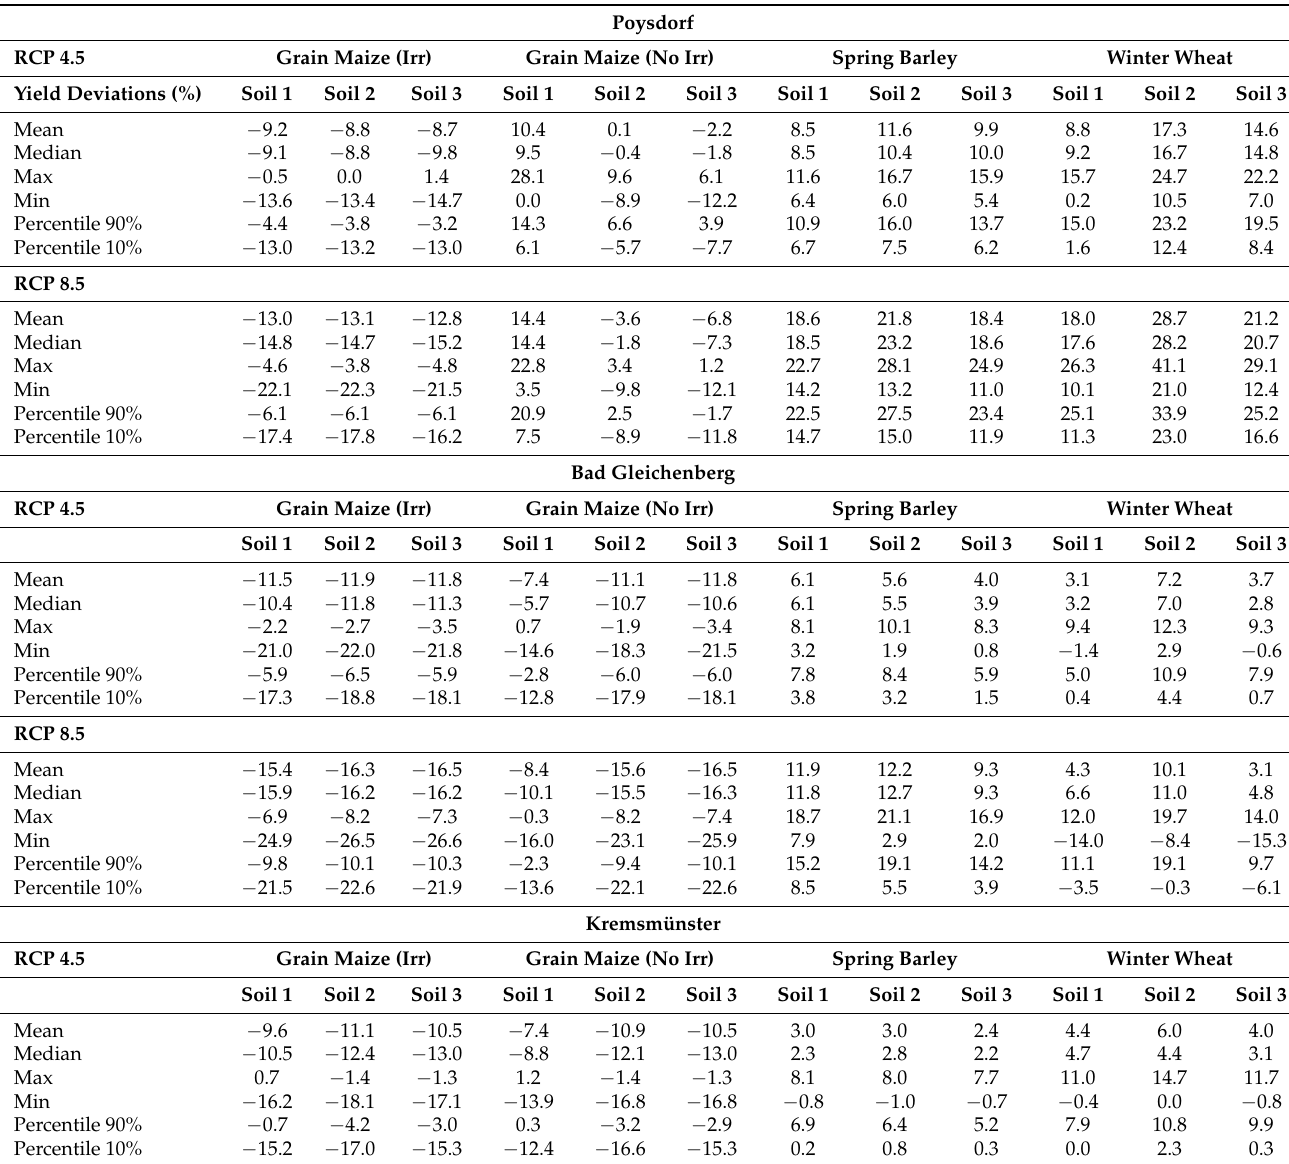
Table A3. Mean, Median, Maximum (Max), and Minimum (Min) values as well as 90th and 10th percentiles across